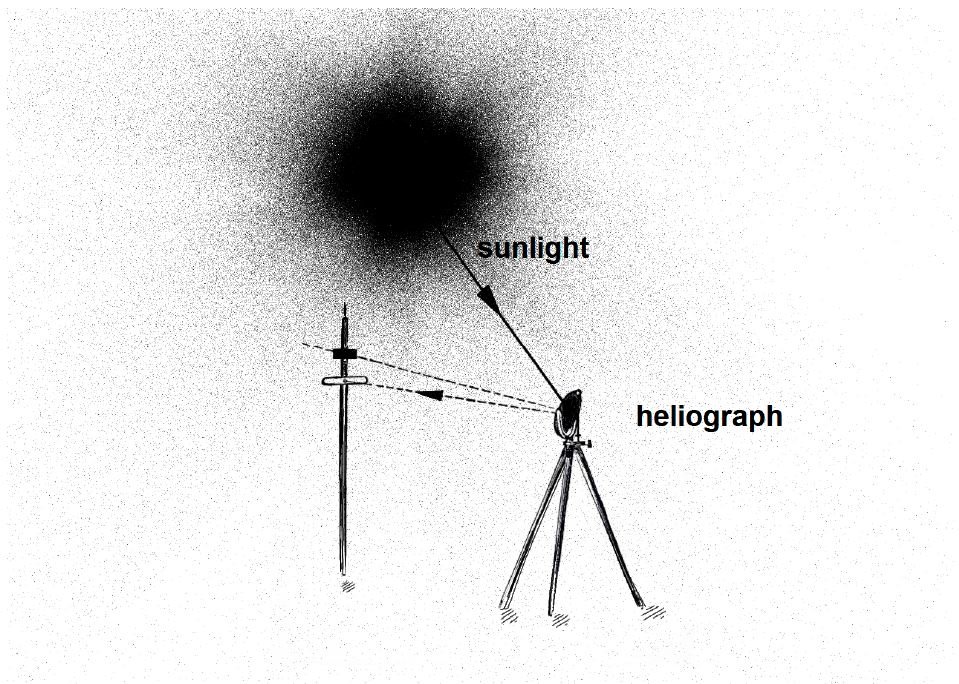
Figure 3. A scheme of a heliograph.